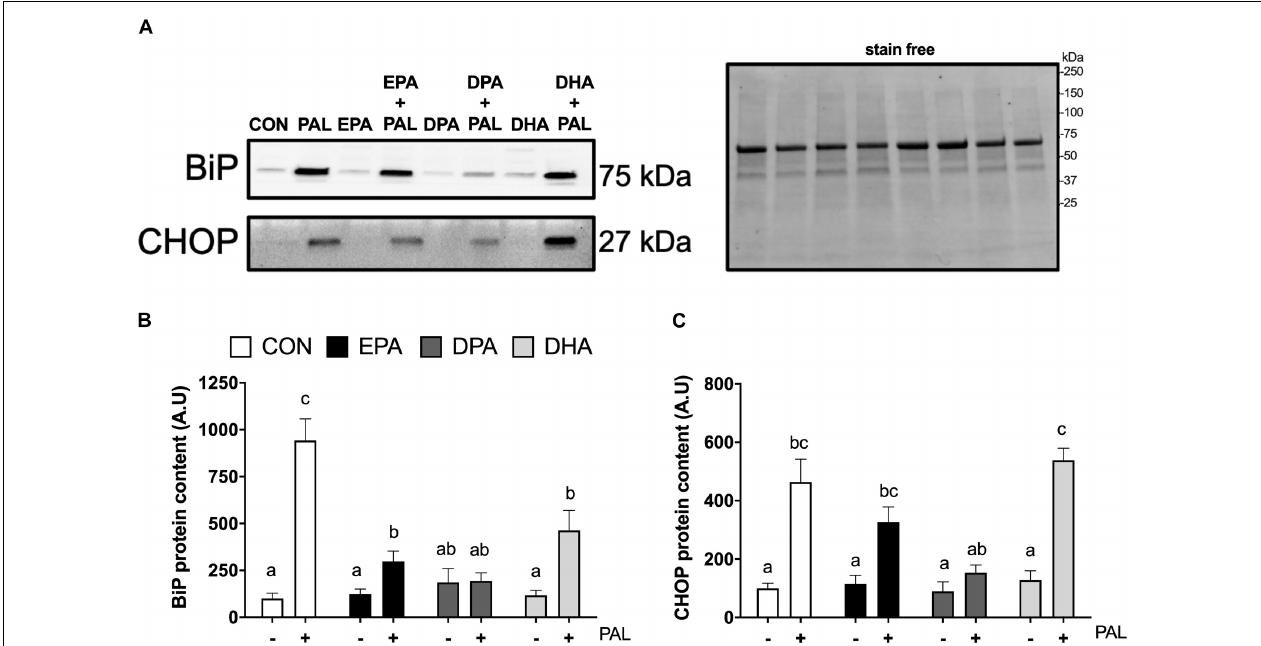
FIGURE 3 | EPA, DPA, and DHA attenuate PAL-induced increases in the ER stress markers BiP and CHOP. Representative images of ER stress proteins BiP and CHOP following 16 h treatment with 500 µ M PAL and/or 50 µ M EPA, DPA or DHA (A) and representative image of a stain free blot used for normalization shown with molecular weight markers indicated. Quantified protein content of BiP (B) and CHOP (C) . In the absence of PAL, little to no CHOP protein was detectable. All densitometry values are expressed relative to protein content determined by stain free imaging and presented in arbitrary units relative to CON. Treatments that do not share letters are considered statistically significant ( p < 0.05; myoblasts were cultured and harvested independently to generate a total sample size of 5 biological replicates). Values are presented as mean ±